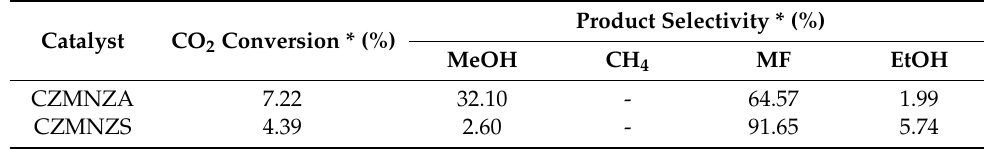
Table 5. Catalytic activity of CZMNZA and CZMNZS at reduction temperature 400 ◦ C.